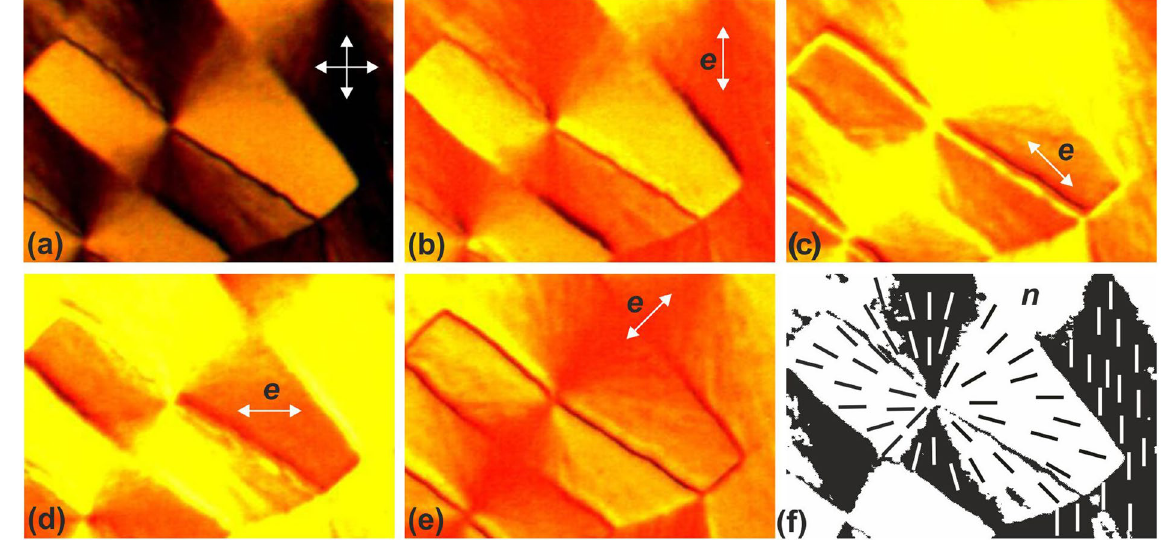
Figure 4. Microphotographs of the dye-doped 5CB domain at certain angles of light polarization e . ( a ) In the crossed polarizers; ( b ) 0°;( c ) 45°; ( d ) 90°; ( e ) − 45°. ( f ) The director field configuration in the surface of